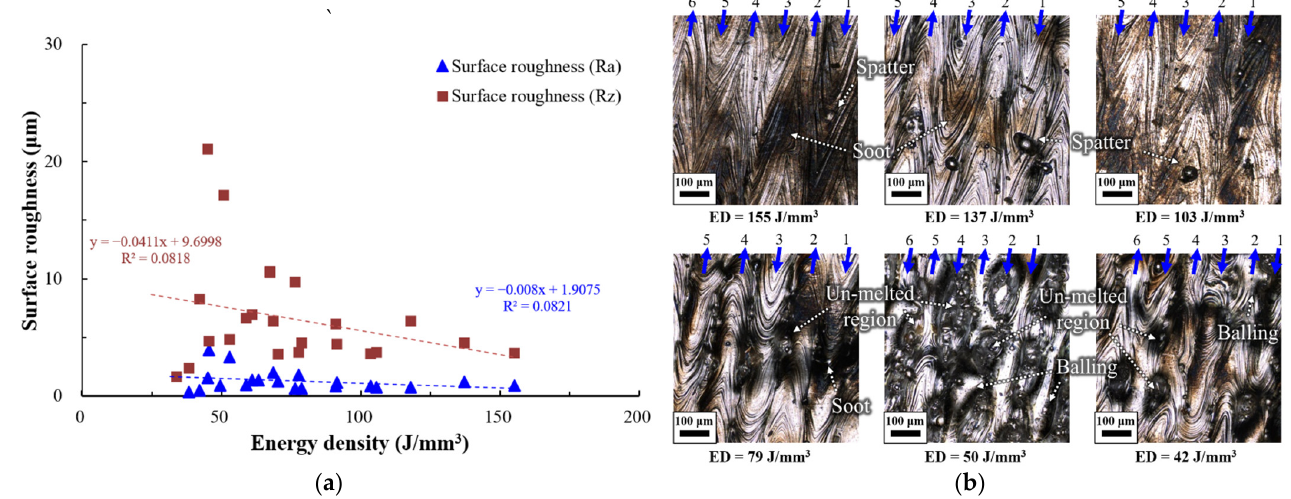
Figure 8. Surface roughness characteristics of deposited specimen for different energy density (J/mm 3 ): ( a ) Plot of surface roughness (μm) according to energy density (J/mm 3 ) and ( b ) Morphology of deposited surface according to the energy density (J/mm 3 ).